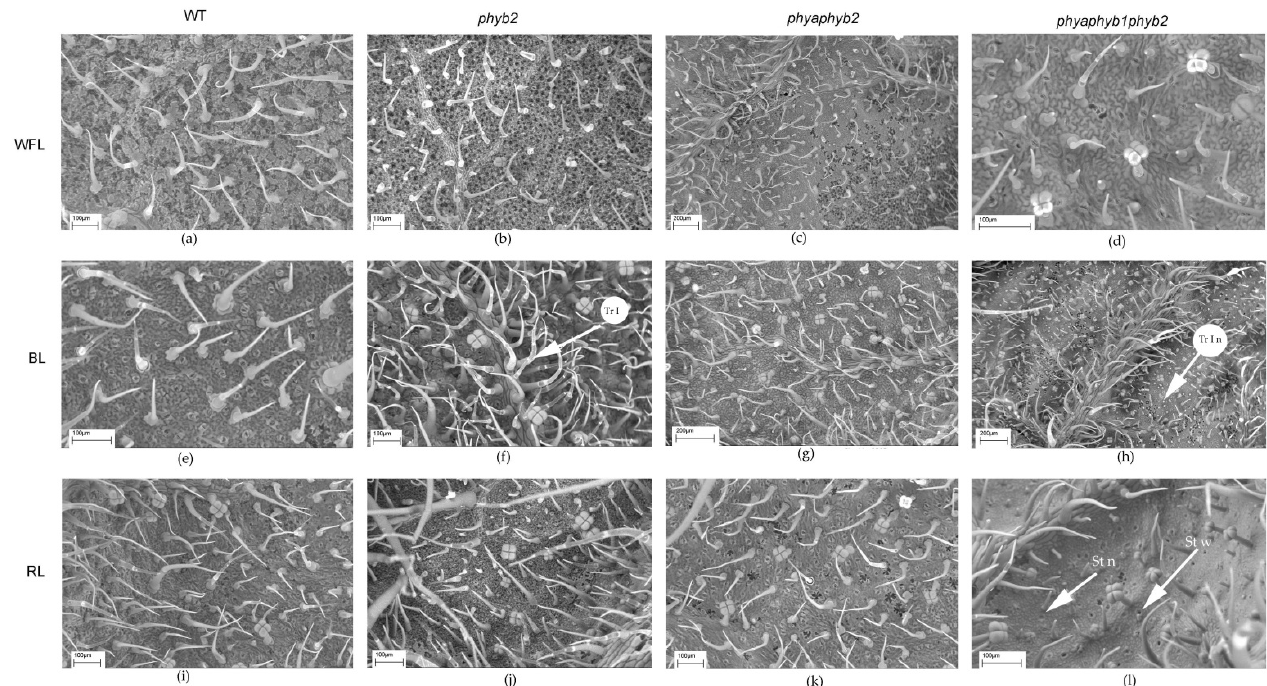
Figure 2. Effect of WFL, BL, and RL on the number of type I secretory trichomes ( a , b ); number of epidermal cells ( c , d ) and number of stomata ( e , f ) per mm 2 on abaxial ( a , c , e ) and adaxial ( b , d , f ) sides of leaves. Different letters indicate significant differences ( p < 0.05) between the experimental treatments. The means ± standard errors, n = 6.